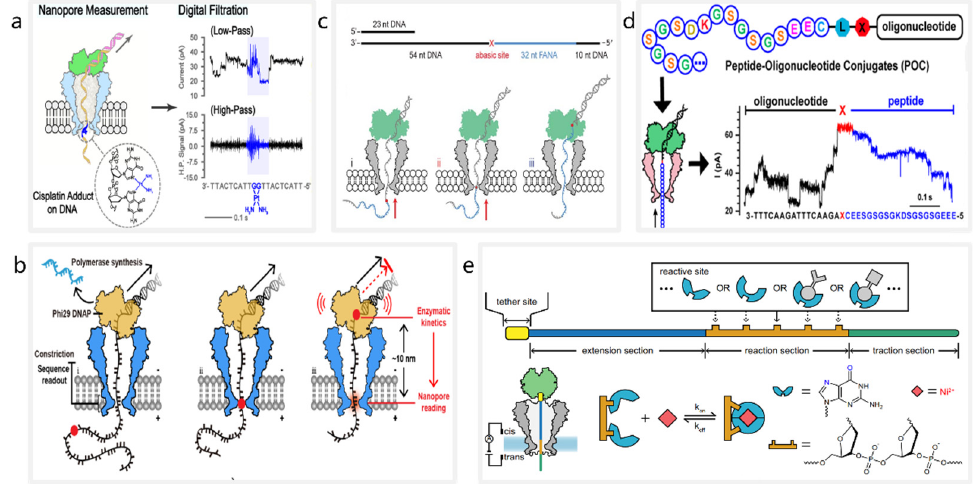
Figure 1. The schematic diagrams of nanopore-based molecular detection systems. ( a ) Detection of cisplatin lesions on DNA. Reproduced with permission from Fubo Ma, ACS Sensors; published by American Chemical Society, 2021. ( b ) Stalling kinetics readout during nanopore sequencing using an MspA nanopore (blue) and a phi29 DNAP (yellow). Reproduced with permission from Jinyue Zhang, Nano Letters; published by American Chemical Society, 2022. ( c ) Sequencing of chimeric DNA (grey) -FANA (cyan) with an abasic spacer (red). Reprinted from [90]. ( d ) Ratcheting motion of a POC using NIPSS. Reproduced with permission from Shuanghong Yan, Nano Letters; American Chemical Society, 2021. ( e ) Detection of inorganic chemical molecules through PNRSS. Reprinted from [95].